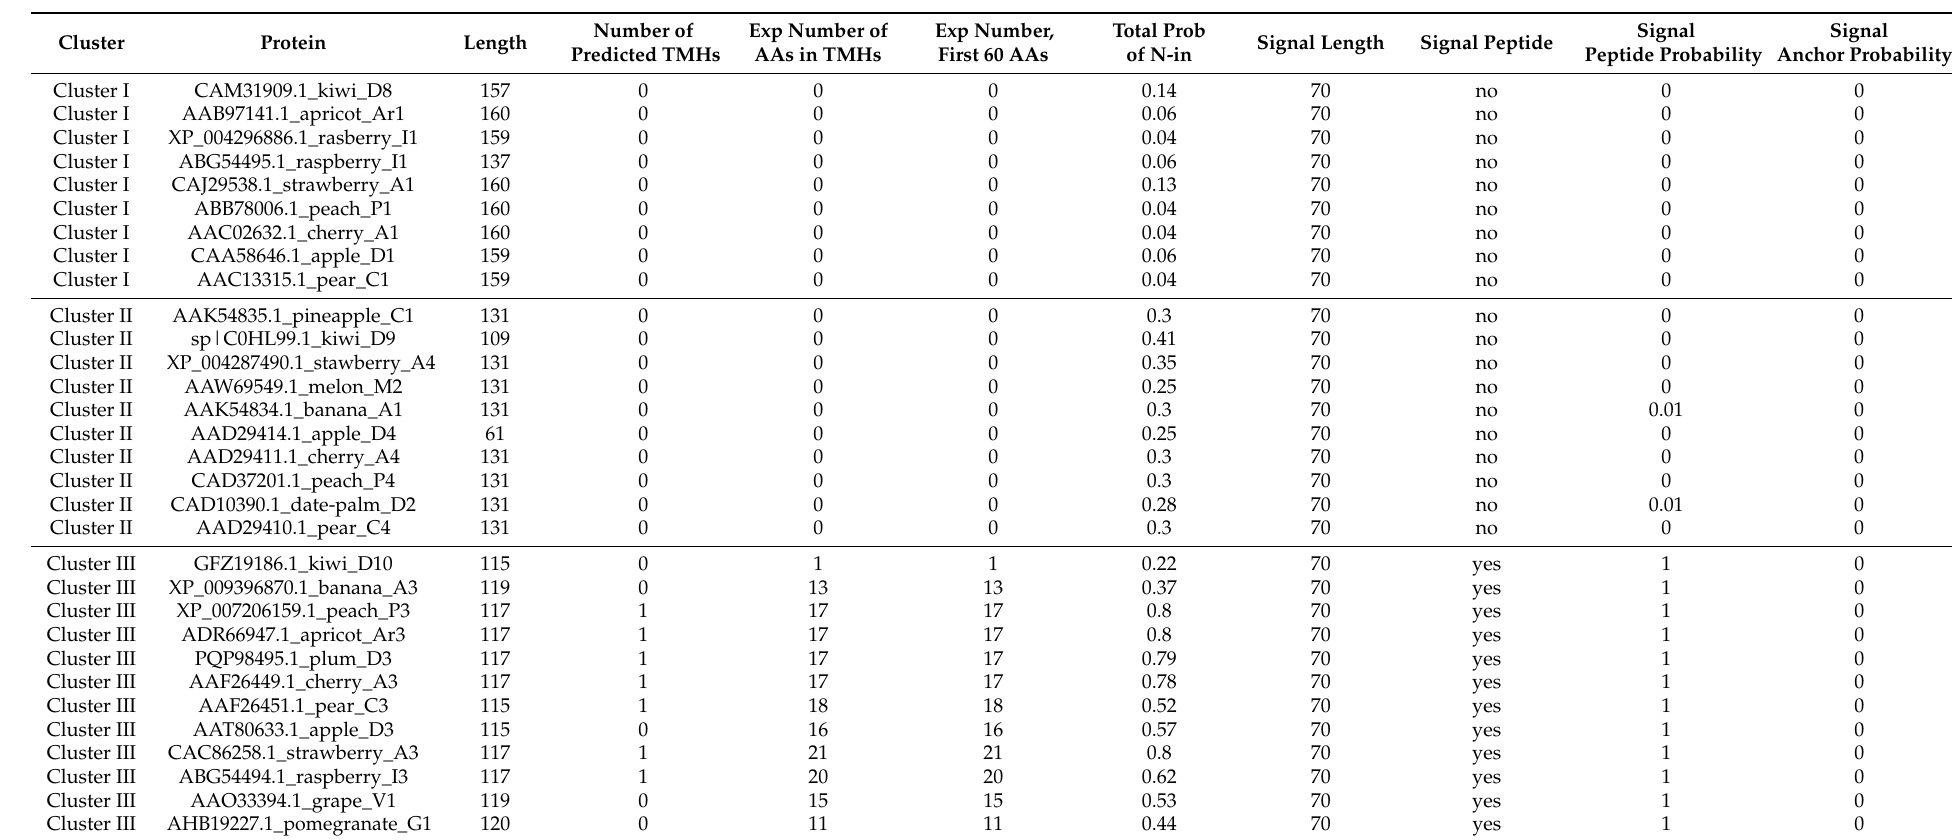
Table 1. Transmembrane and signal peptide analysis